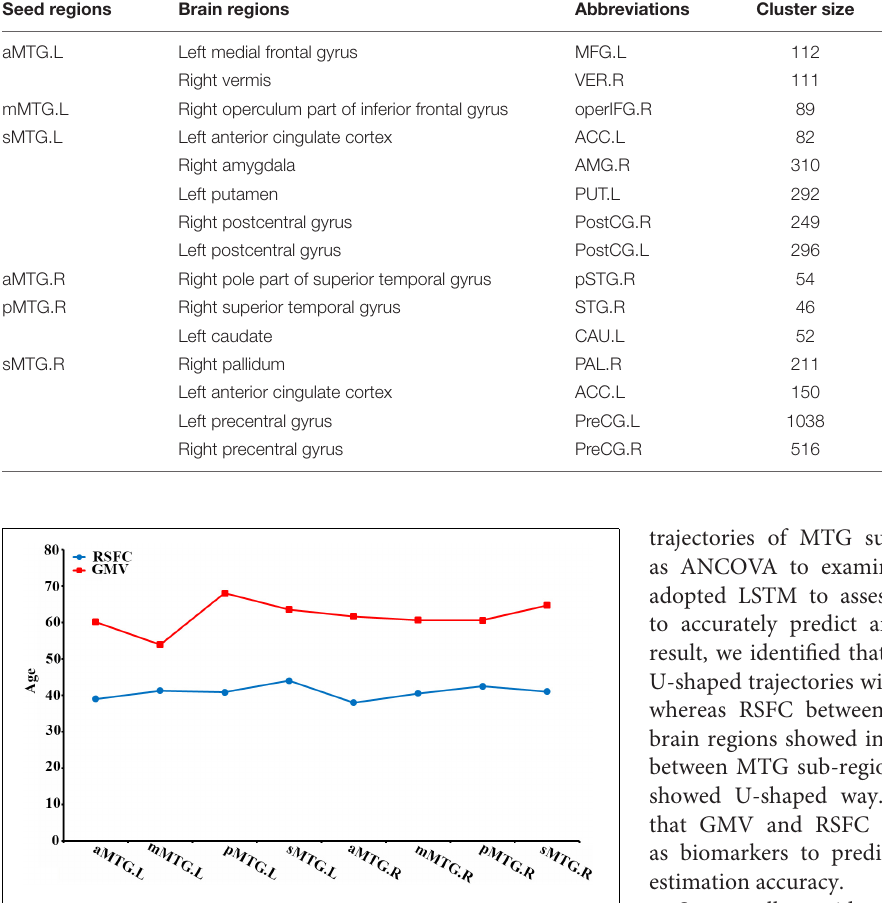
FIGURE 3 | Maturation ages of RSFC and GMV in the MTG